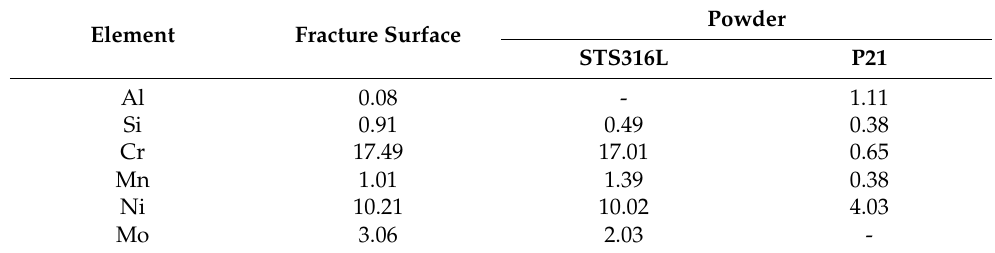
Table 3. Compositions of the fracture surface of the FGM tensile test specimen and deposited powders (wt%). Element Fracture Surface